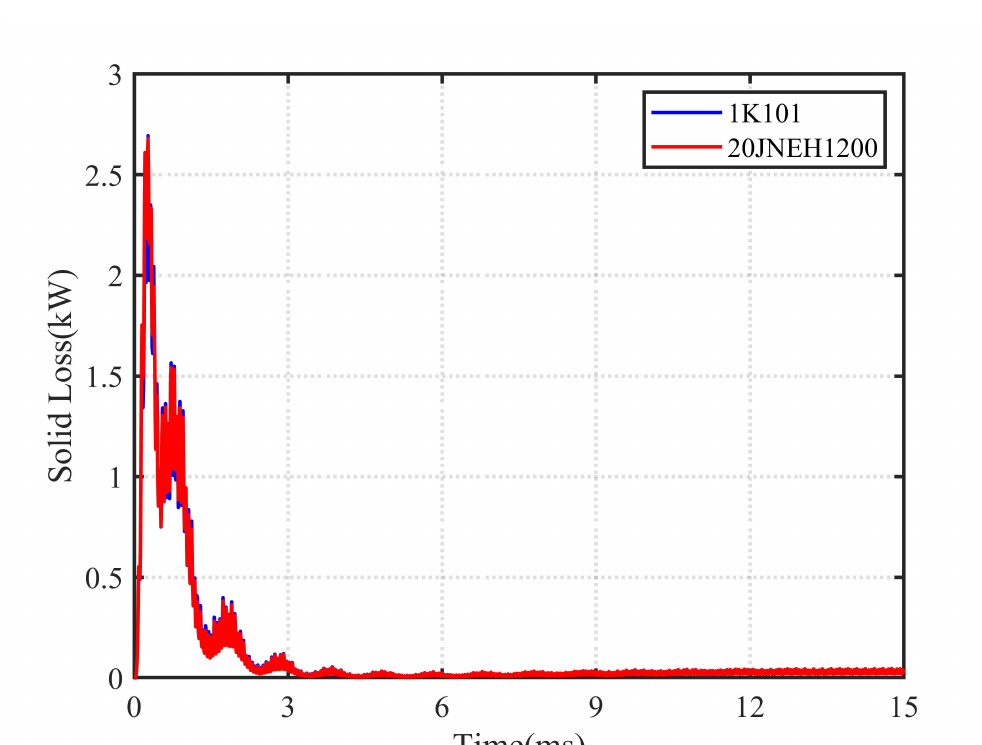
Figure 6. Comparison of the Copper Loss in the Stator Winding.